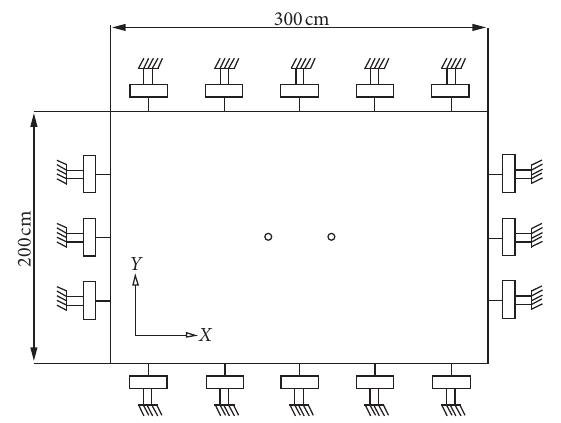
Figure 3: Diagram of the model.